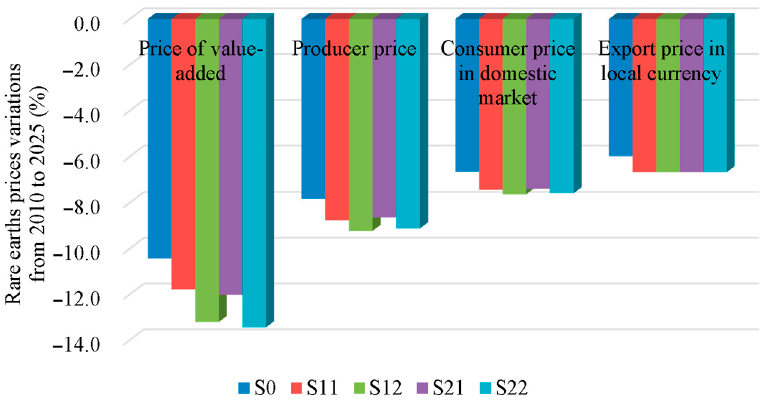
Figure 4. Rare earths prices variations from 2010 to 2025 (%).